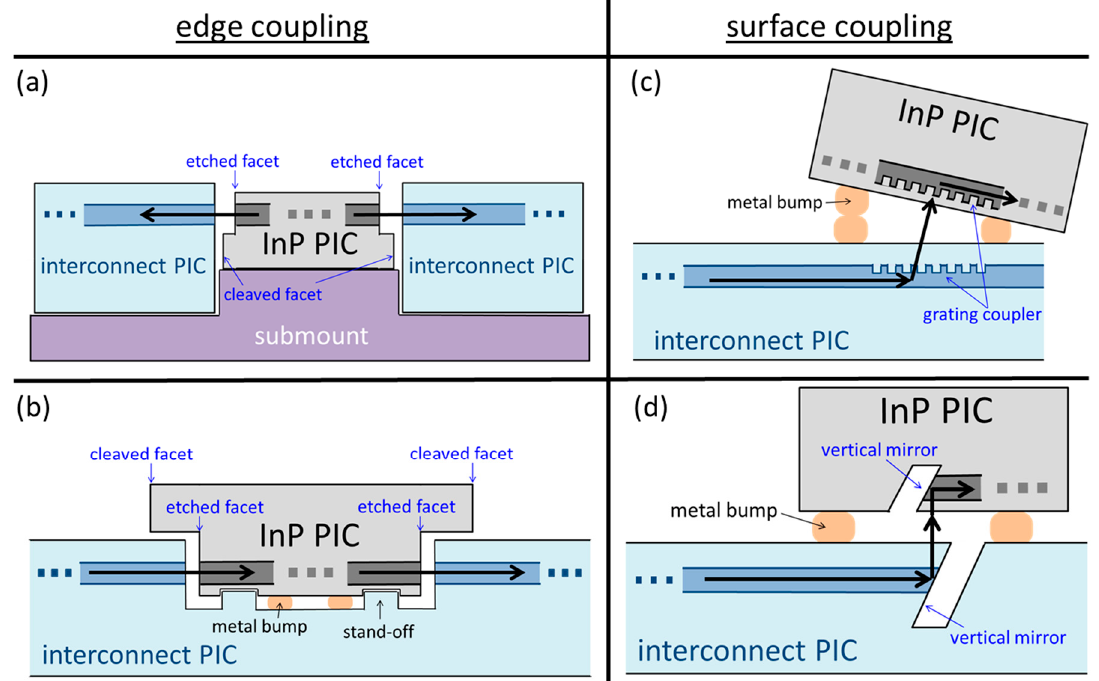
Figure 7. Illustration of four of the most common approaches for hybrid integration of InP PICs with PICs from other technologies. ( a ): edge-coupling method through active alignment between the PICs ( b ) edge-coupling approach employing flip-chip alignment ( c ): surface-coupling approach with grating couplers ( d ): surface-coupling approach using 45° vertical mirrors.